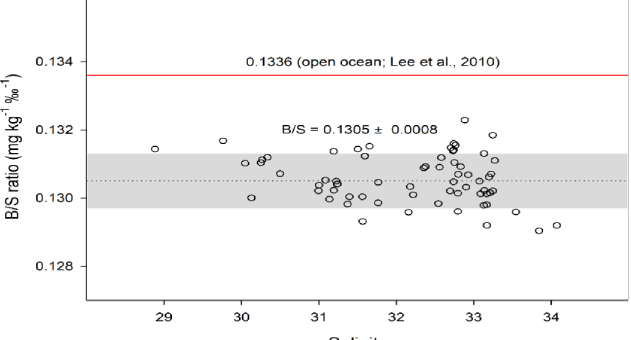
Fig. 4 Variation in the boron to salinity ratios (B/S) across all sample types. Values are shown relative to the established values of Lee et al. 11 for 5 open ocean regions and Olafsson et al. 15 in the North Atlantic and polar regions: ( a ) Total B (all samples from this study) versus salinity, b B/S ratio (all samples from this study) versus salinity, and ( c ) B/S ratio in open seawater samples from this study versus salinity where the gray shaded area represents 1 standard